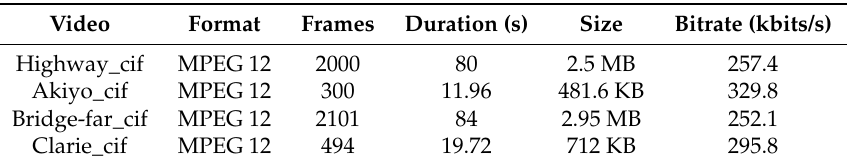
Table 2. Features of videos used in the simulations.